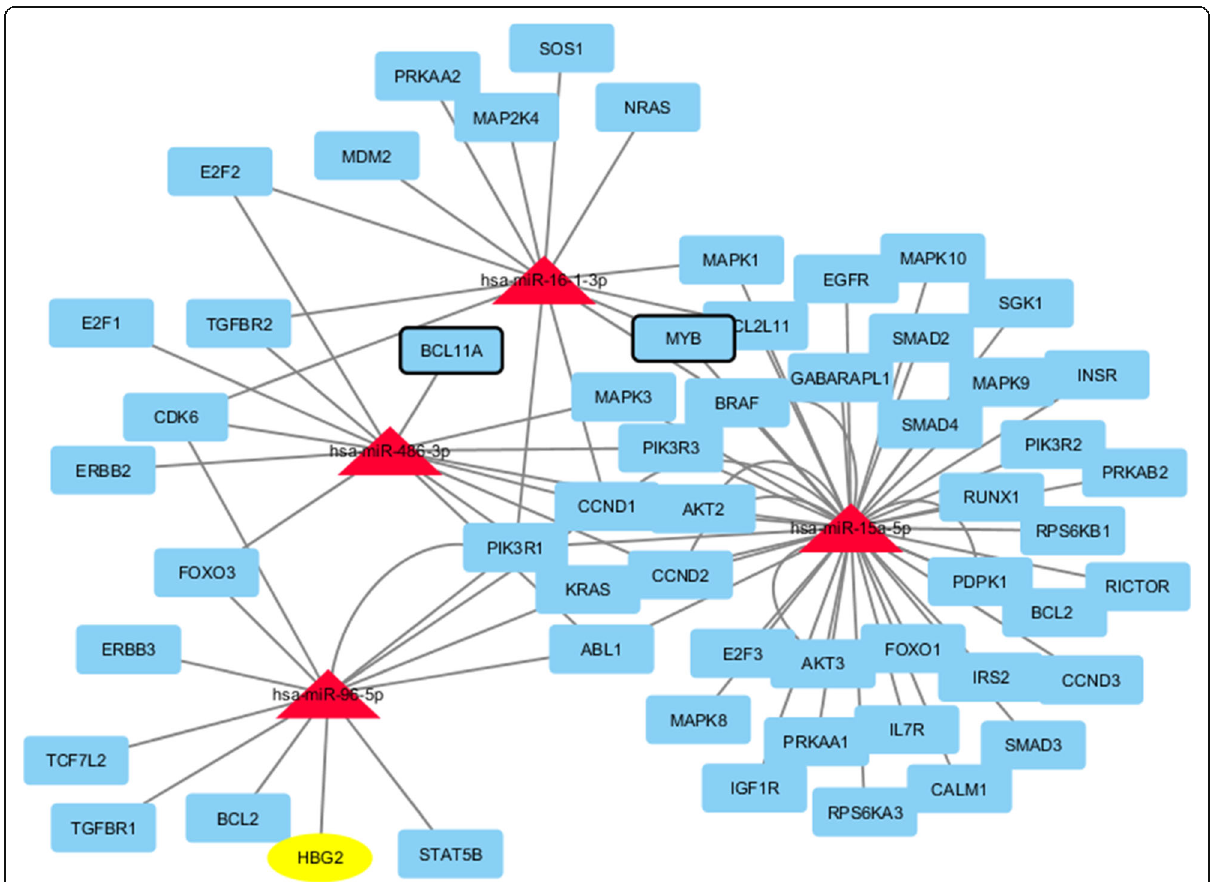
Fig. 4 The studied microRNAs and their target genes involved in highly enriched pathways related to